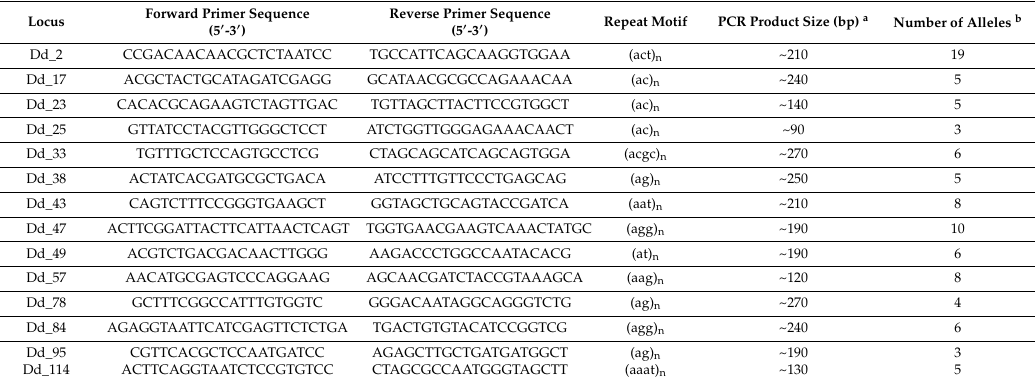
(Table 3). No significant di ff erences were detected between the values of observed (Ho) and expected heterozygosities (He). Table 2. Characteristics of 14 microsatellite markers identified in D. dendriticus . Locus